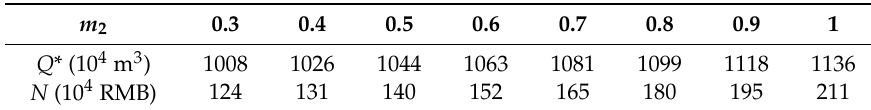
Table 5. The results of experiment scheme